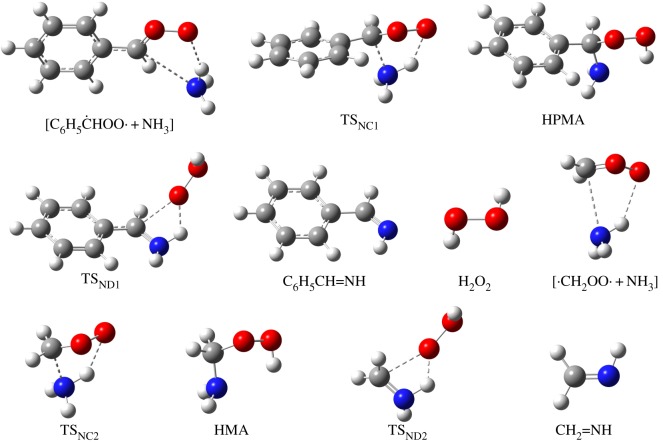
The structures of pre-reaction complexes, transition states, intermediates, and stabilized products in the reactions of C6H5ĊHOO· + NH3 and ·CH2OO· + NH3. All these structures are optimized at the B3LYP/6-311++G(2d,2p) level.